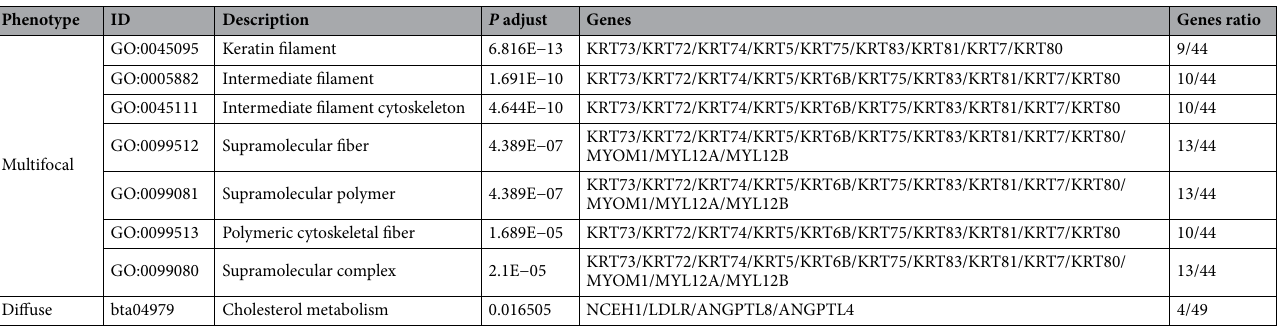
Table 4. GO and pathway analysis using the candidate genes associated with the multifocal and diffuse